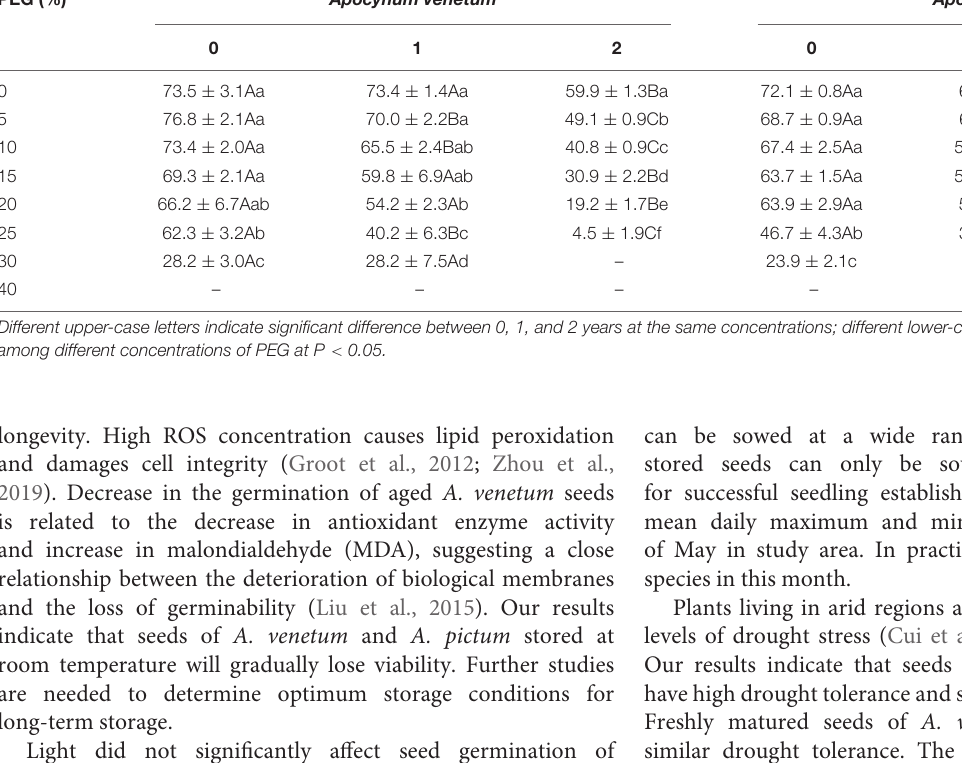
TABLE 2 | Effect of PEG on germination index of Apocynum venetum and Apocynum pictum seeds stored for 0, 1, or 2 years. PEG (%) Apocynum venetum Apocynum